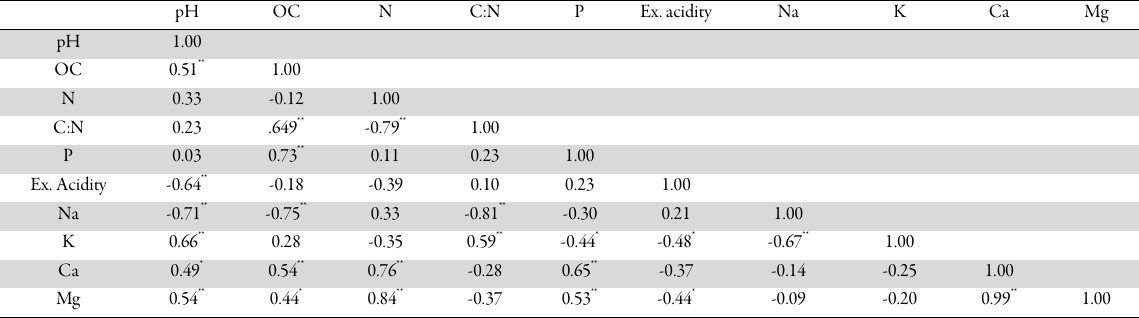
Values are correlation coefficient *significant at 0.05 level and **significant at 0.01 level . Table 5. Pearson correlation for soil chemical properties in the subsoil of five land use